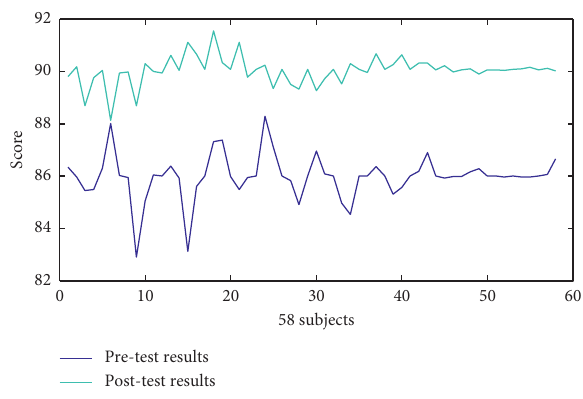
Figure 8: Comparison of pretest and posttest scores of 58